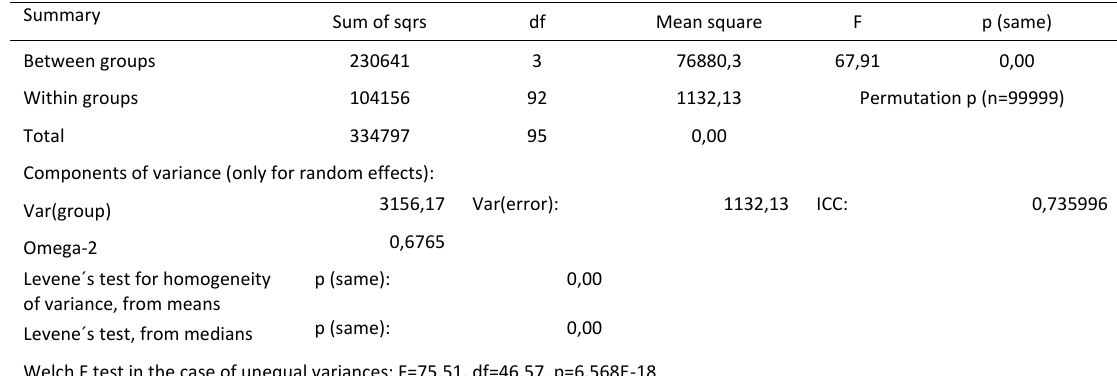
Tabel 1: Anova one way between morphotype